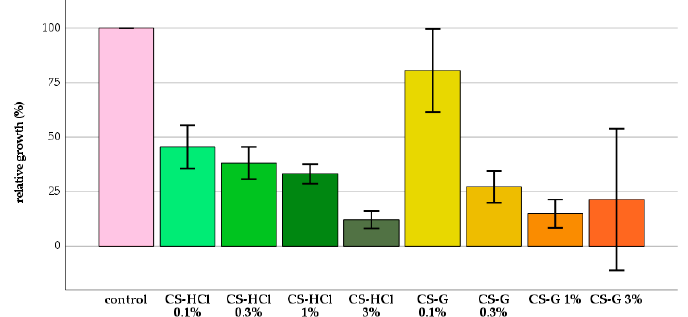
Figure 1. Mean relative growth (%) in each group, confidence interval (CI) 95%; chitosan glutamate (CS-G), chitosan-hydrochloride (CS-HCl).